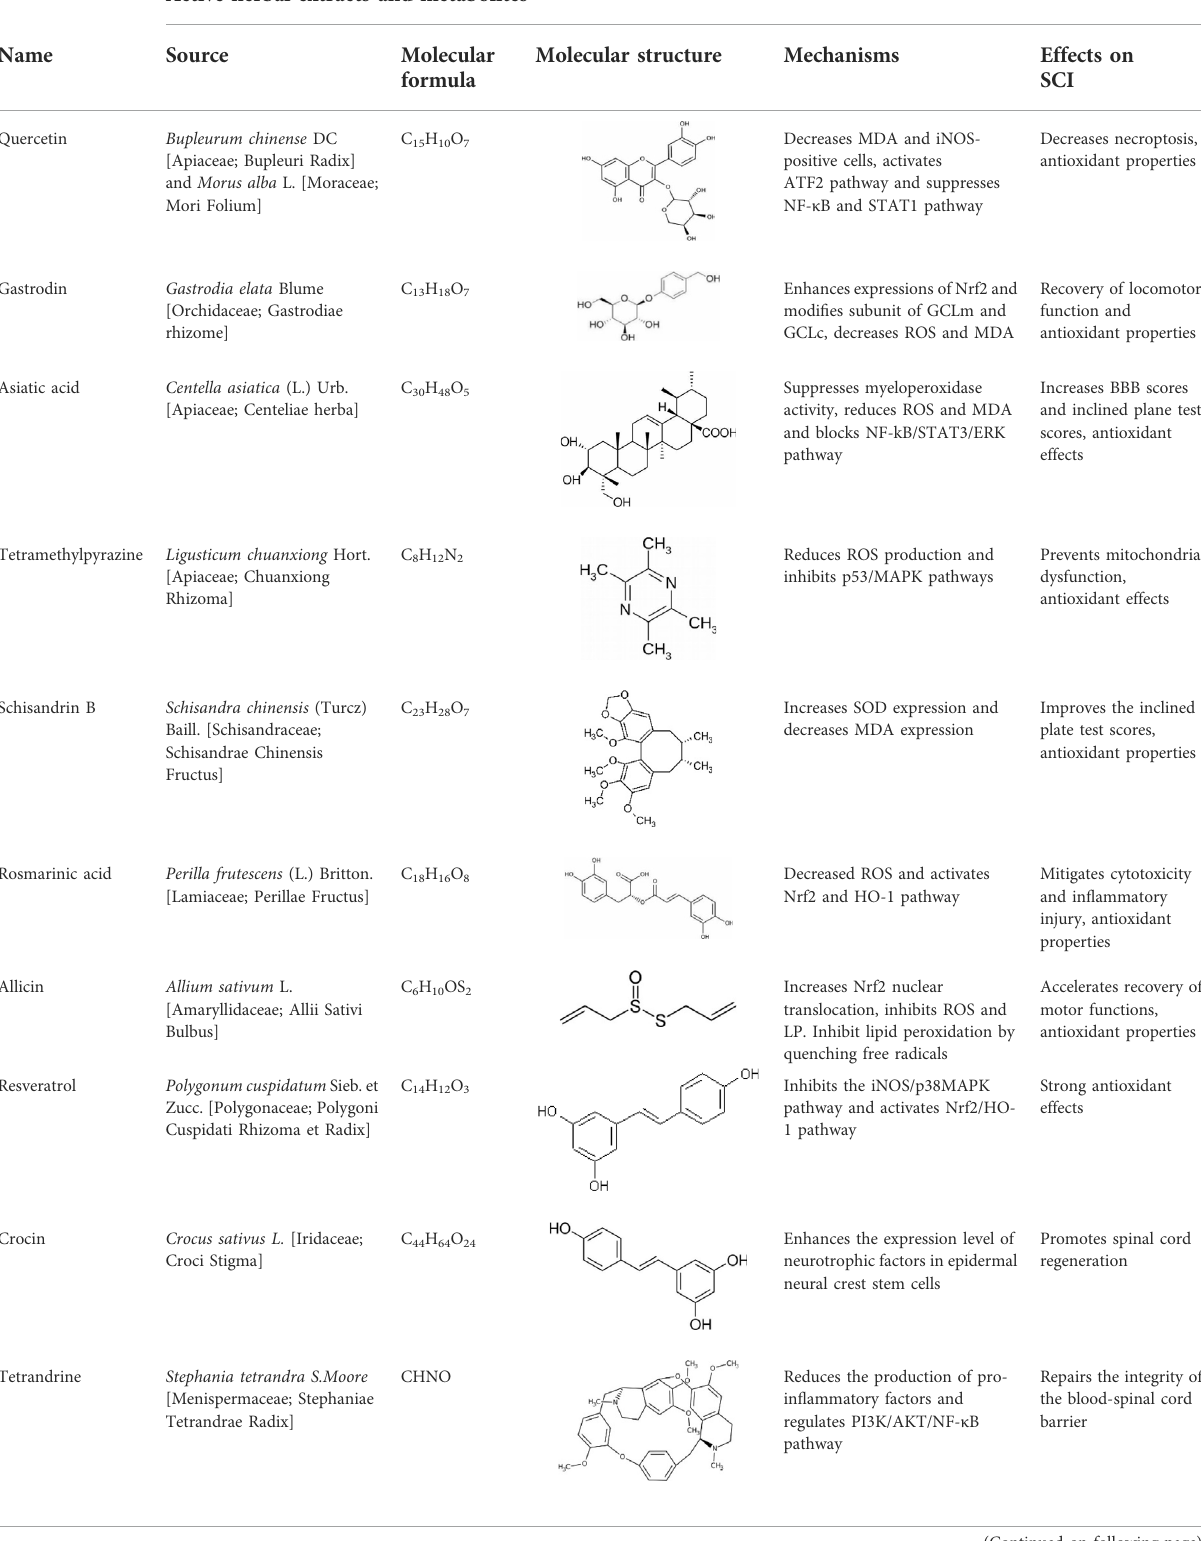
TABLE 1 Therapeutic intervention with active herbal extracts and